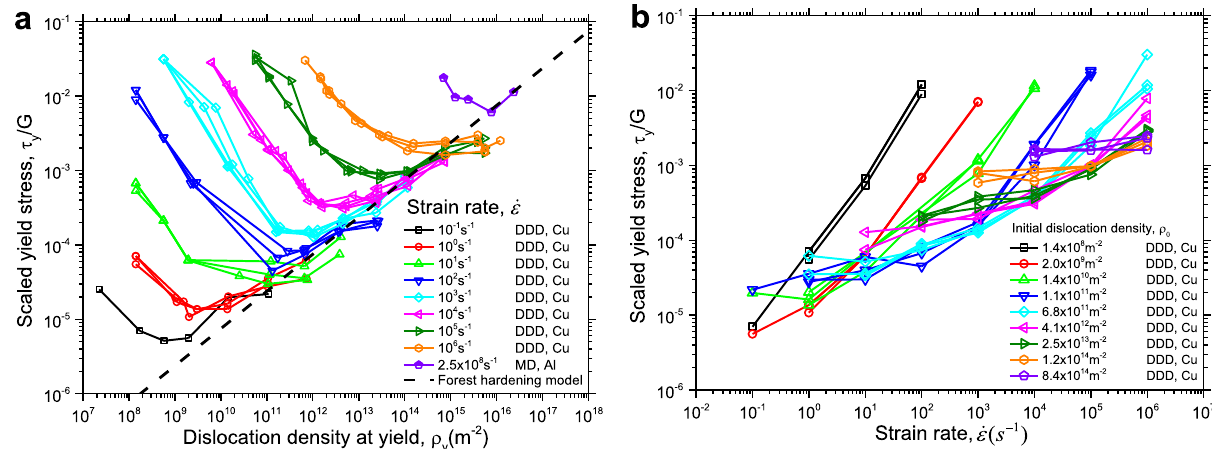
Fig. 1 Yield stress as predicted from current DDD/MD simulations. a Scaled yield stress as a function of dislocation density at yield for different strain rates. b Scaled yield stress as a function of strain rate for different initial dislocation densities. In Fig. b , no MD points are shown because the MD simulations were conducted at only one strain rate. DDD is abbreviation of discrete dislocation dynamics and MD is